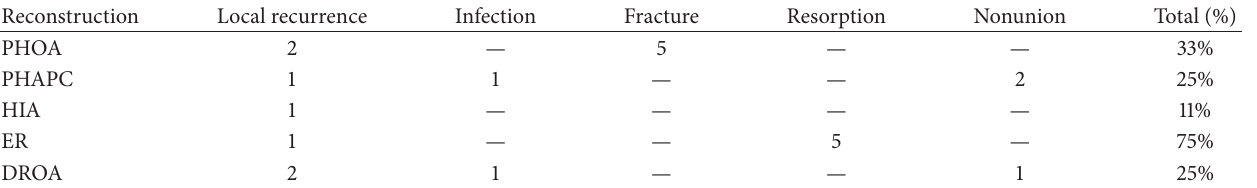
Table 1: Allograft complications according the different types of reconstructions.